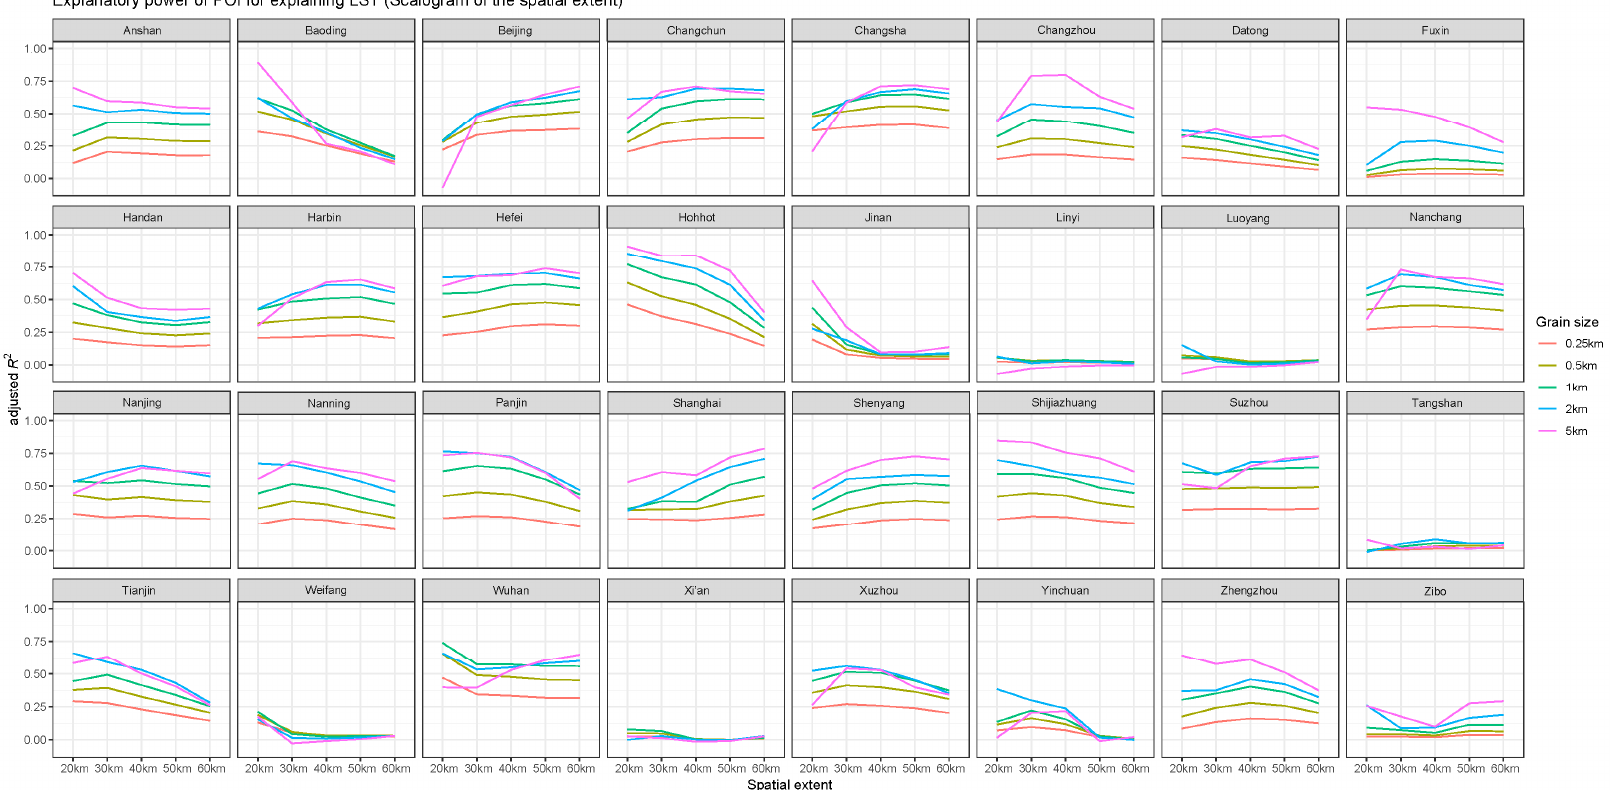
Figure A11. Explanatory power of POI for explaning LST(Scalogram of the spatial extent)